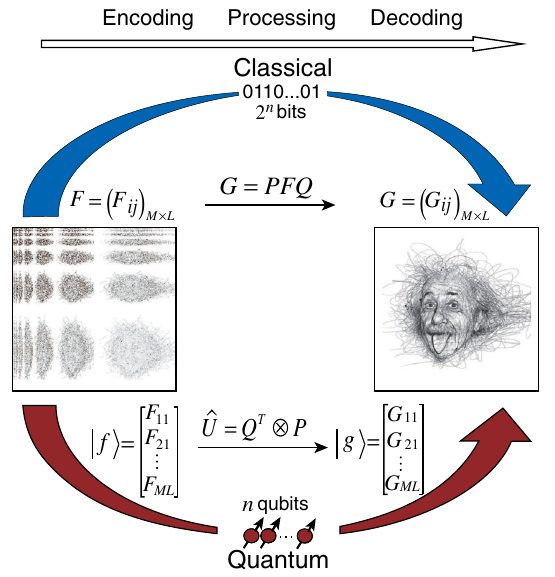
FIG. 1. Comparison of image processing by classical and quantum computers. F and G are the input and output images, respectively. On the classical computer, an M × L image can be represented as a matrix and encoded with at least 2 n bits [ n ¼ ⌈ log 2 ð ML Þ ⌉ ]. The classical image transformation is con- ducted by matrix computation. In contrast, the same image can be represented as a quantum state and encoded in n qubits. The quantum image transformation is performed by unitary evolution ˆ U under a suitable